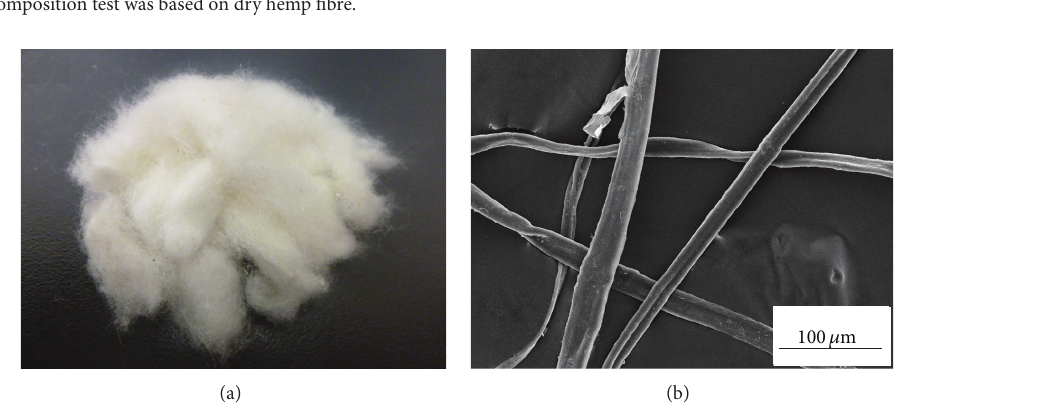
Figure 1: Photo and micrograph of